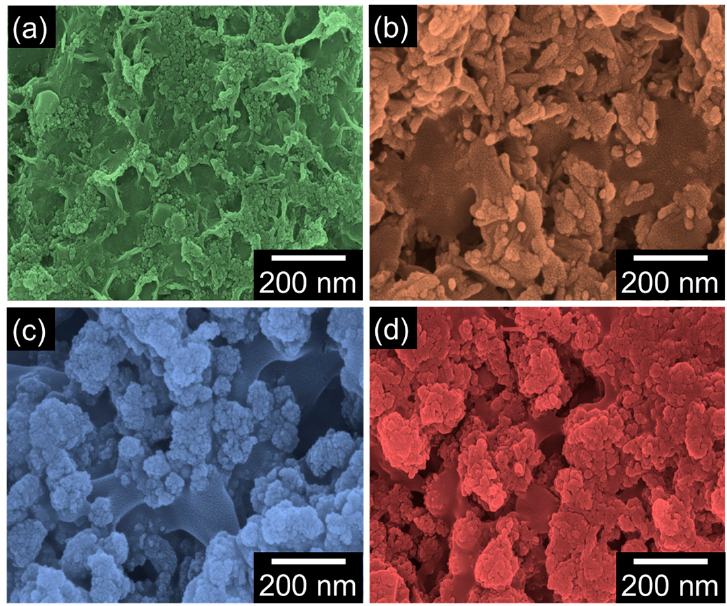
Figure 3. FE-SEM images of the SBF-immersed biocomposites for the in vitro bioactivity test: ( a ) nHAP/CS, ( b ) Eu-nHAP/CS, ( c ) Y-nHAP/CS, and ( d ) Eu,Y-nHAP/CS. ( a ) nHAP/CS, ( b ) Eu-nHAP/CS, ( c ) Y-nHAP/CS, and ( d )